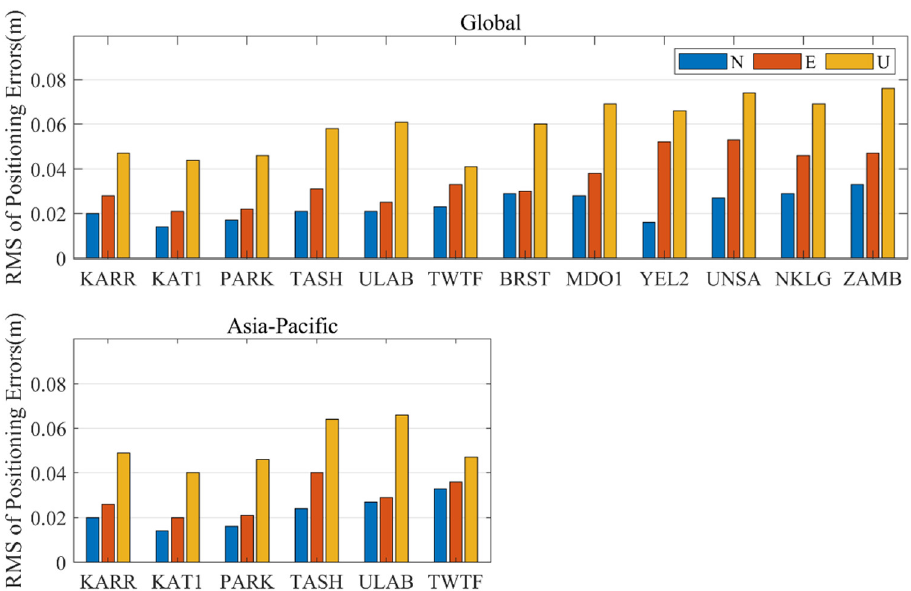
Figure 18. Kinematic PPP results using a different clock offset.